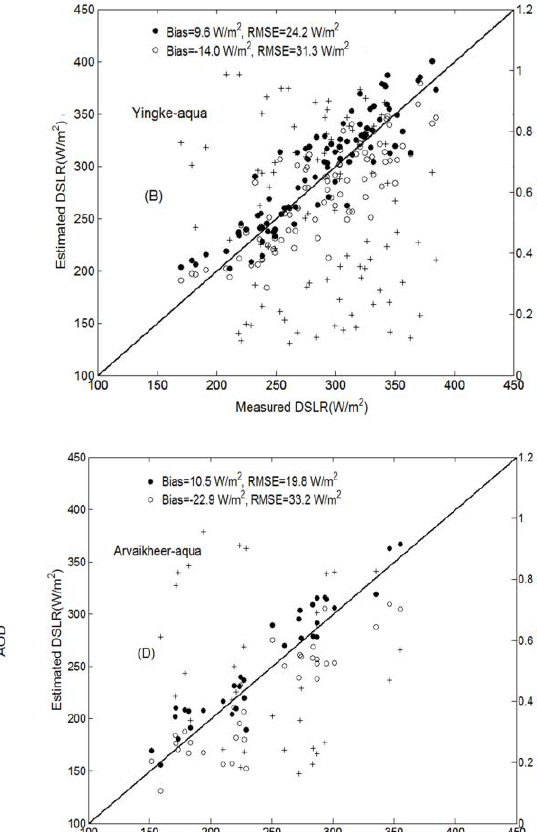
Figure 12. The retrieval errors between DSLR extracted from MODIS data with the proposed (solid circles) and DSLR cl methods (hollow circles) and those groundbased measurements versus AOD at two test sites for dust aerosol conditions at the moment of MODIS overpass. ( A ) Yingke-terra; ( B ) Yingke-aqua; ( C ) Arvaikheer-terra; ( D ) Arvaikheer-aqua. At the Yingke site, most of the dust aerosols occur in spring and autumn, with 118 days of corresponding data for Terra and 89 days for Aqua. The RMSEs of the proposed model are 20.4 W/m 2 and 24.2 W/m 2 for Terra and Aqua, respectively, and the biases are 2.7 W/m 2 and 9.6 W/m 2 , respectively. The retrieval errors are from −40 to 50.8 W/m 2 and from −50.4 to 59.8 W/m 2 for Terra and Aqua, respectively. For the Arvaikheer site, there are 39 days of corresponding data for Terra and 34 days for Aqua, and most dust aerosols occur in spring and early summer or autumn. The RMSEs of the proposed model are 23.2 W/m 2 and 19.8 W/m 2 for Terra and Aqua, respectively, and the biases are 7.8 W/m 2 and 10.5 W/m 2 , respectively. The retrieval errors are from −51 to 49.2 W/m 2 and from −39.3 to 38.9 W/m 2 for Terra and Aqua, respectively. The performances of DSLR cl model degrade severely compared to previous studies [60,66], and the RMSEs can even reach 40 W/m 2 in Yingke site, which is the reason that ALRF and coefficient adjustments are not considered in the model. Dust aerosol can not only generate ALRF but also affects the TOA radiance observed by each bands, especially for bands 29 and 31, the maximum rate variations could reach ±3.5%. Consequently, it should be taken into account the influence of dust aerosol on developing the DLSR estimation model. As we can see in Figure 12, the proposed method performs better under both small and heavy aerosol conditions for the aerosol-dependent corrections are made. Considering that there are variations of TOA radiance when dust aerosol happens and coefficient adjustment has been made in the proposed method, it also can acquire relatively high accuracy DSLR in some of the larger WVC conditions. However, it is obvious that that the RMSEs of the proposed model at the two sites are higher than those in the simulated data. Considering that the ground data measured at the two sites use a point-based scale, whereas the retrieved value from